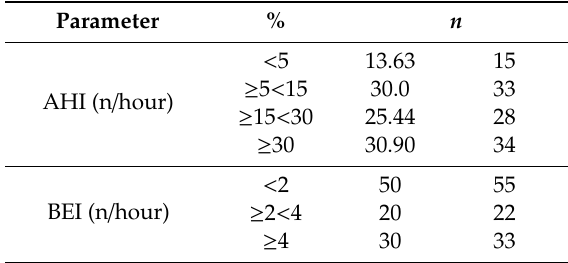
Table 2. The prevalence of obstructive sleep apnea and sleep bruxism in the studied group.